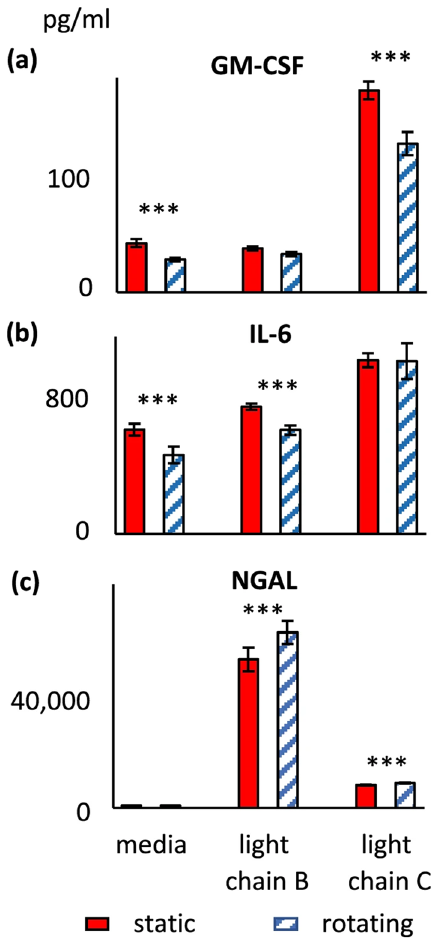
Figure 9. Effect of rotation in cell spinpods on cytokine release from renal cells. RPTEC/TERT1 cells on Cytodex carrier beads were cultured in cell spinpods under rotating conditions ( ) or static conditions ( ) in the presence of myeloma light chains from donor B, myeloma light chains from donor C, or media. After 48 h, supernatants were harvested for assay of cytokines. Bars presented mean concentration (pg/mL) of GM-CSF, panel ( a ), IL-6, panel ( b ), and NGAL panel ( c ), in the cell supernatant; error bars are ± SEM. Asterisks indicate where differences in the distributions between rotating and static groups were statistically significant, e.g. p < 0.05, by one-tailed Mann–Whitney U test. Rotation induced significantly greater quantities of GM-CSF in the media control ( p = 0.004, W = 39, n 1 = 7, n 2 = 6) and after stimulation with myeloma light chains from donor C ( p = 0.005, W = 33, n 1 = 7, n 2 = 5). Rotation induced significantly greater quantities of IL-6 after culture in media alone ( p = 0.036, W = 34, n 1 = 7, n 2 = 6) and with myeloma light chains from donor B ( p = 0.001, W = 41, n 1 = 7, n 2 = 6). Rotation significantly reduced the quantities of NGAL released after stimulation with myeloma light chains from donor C ( p = 0.024, W = 5, n 1 = 7, n 2 = 5) and myeloma light chains from donor B (Fig. 8c, p = 0.05, W = 9, n 1 = 7, n 2 =